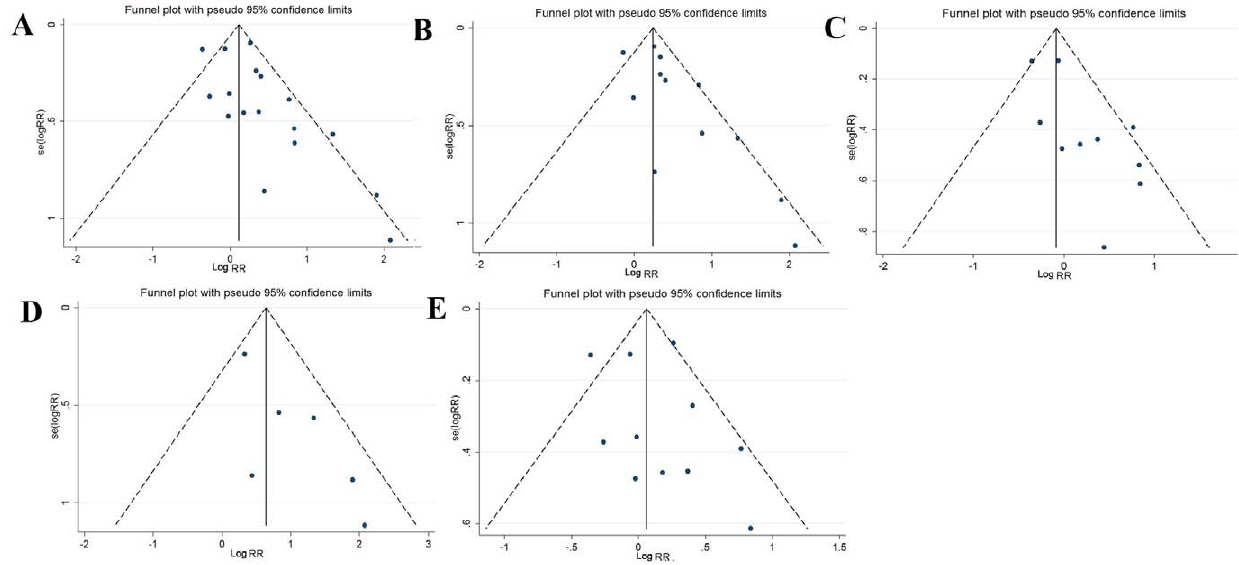
Figure 3. Funnel plot analysis to detect publication bias. Each point represents a separate study for the indicated association. A Funnel plot for all studies; B funnel plot for job title data; C funnel plot for quantitative data; D funnel plot for clinical examination data; E funnel plot for death certificate data.